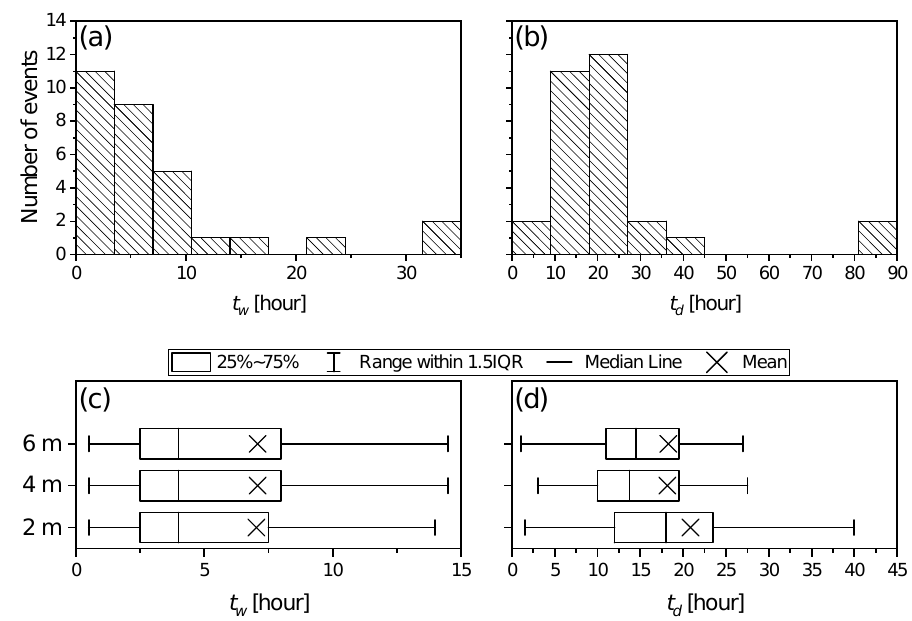
Figure 6. Characteristics of ( a ) wetting ( t w ) and ( b ) drying ( t d ) phases duration described by histograms of t w and t d ; as well as the vertical distribution of ( c ) t w and ( d ) t d between LWS installed at three different heights: 2, 4, and 6 m. The variability is described by the interquartile range